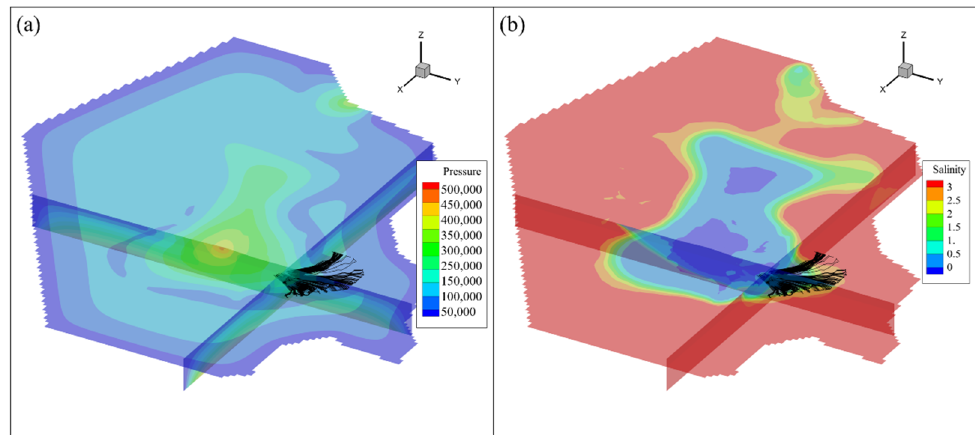
Figure 9. The steady-state flow, salinity field, and Q1 paths in the base case. ( a ) The pressure distribution and Q1 paths on the repository depth and two vertical profiles across the center of the repository. ( b ) The salinity field and Q1 paths on the repository depth and two selected profiles across the center of the repository.